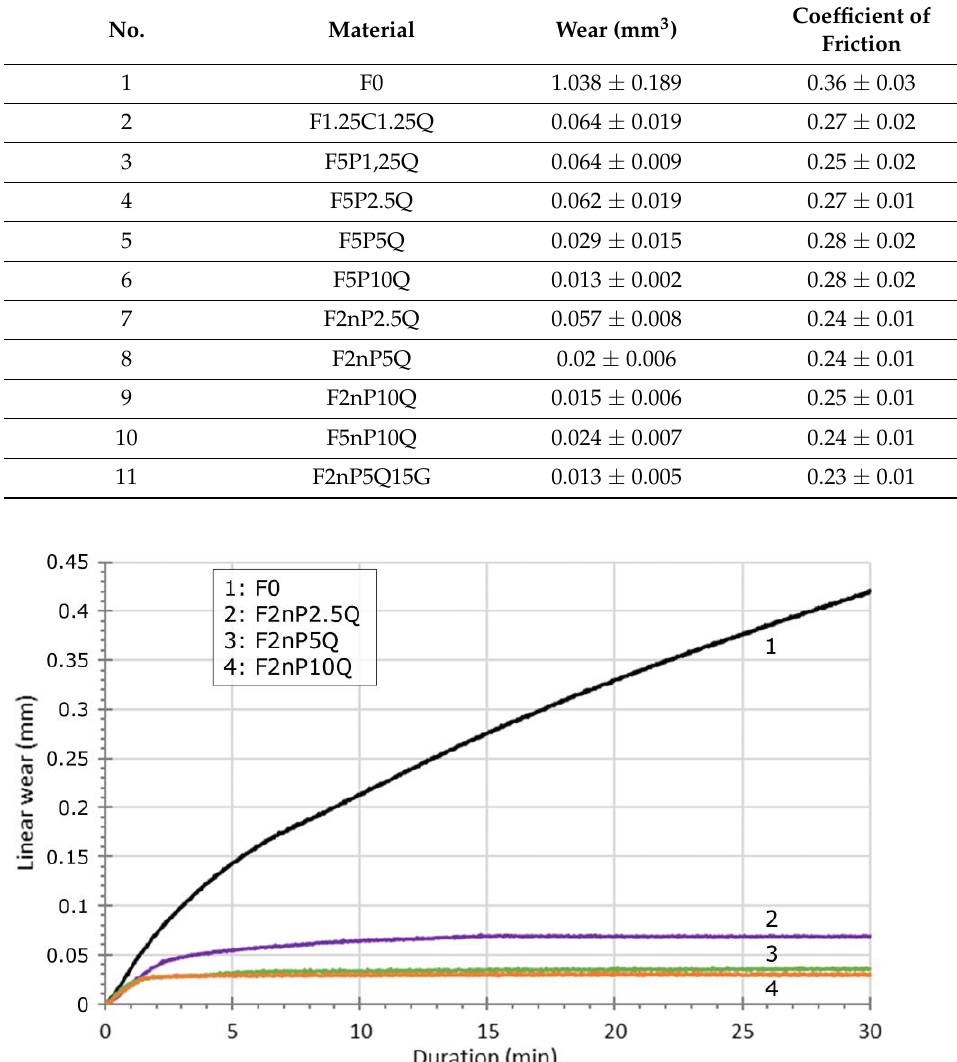
Figure 8. Time dependence of linear wear for unfilled FEP and FEP-nano PTFE-QC Al 73 Cu 11 Cr 16.